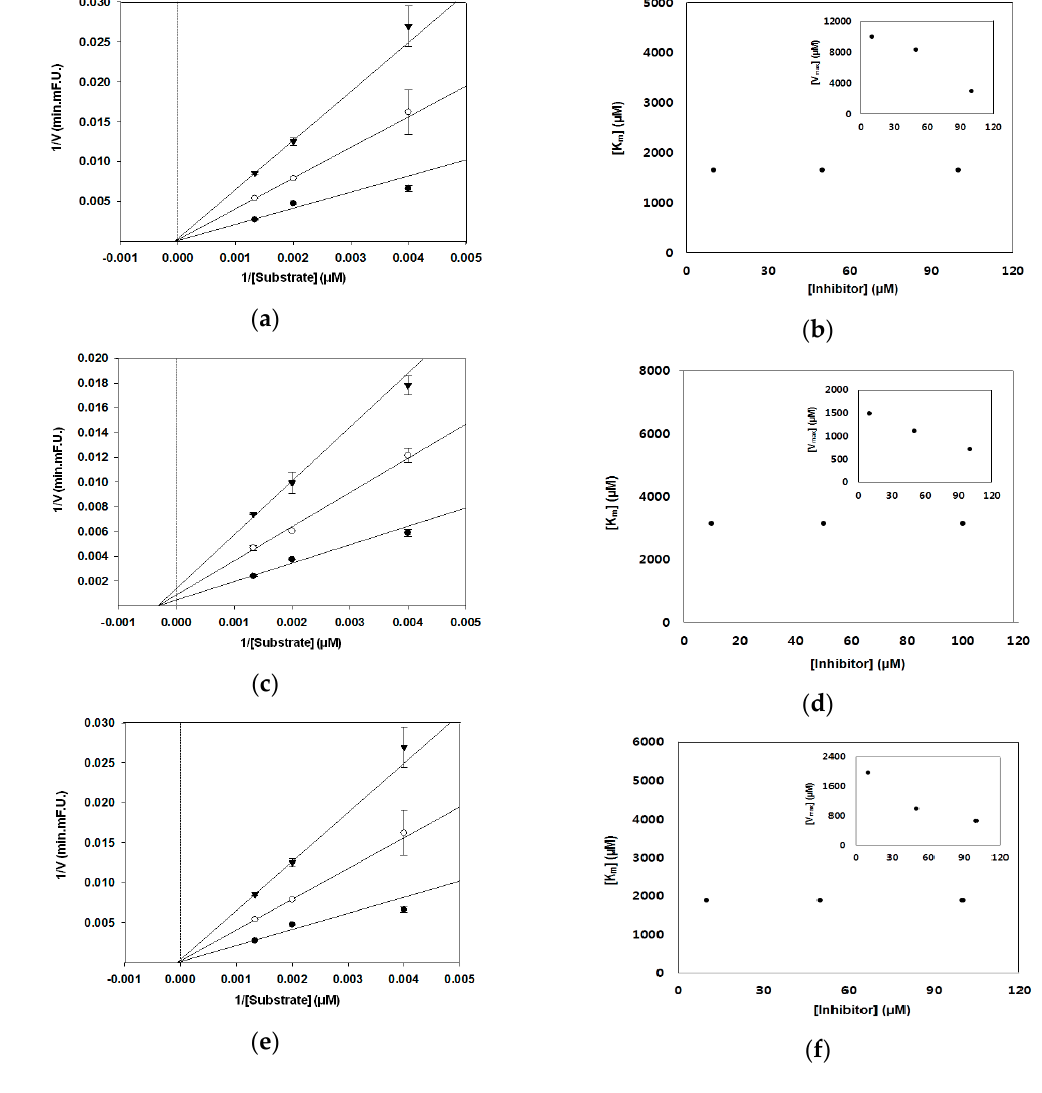
Figure 3. Lineweaver–Burk plot of the reciprocal initial velocities of ( a ) nobiletin, ( c ) tangeretin, and ( e ) sinensetin against BACE1 concentration at different polymethoxyflavone (PMF) concentrations: 10 M ( ● ); 50 μ M ( ○ ); 100 μ M ( ▼ ). The Km values as a function of the concentration of ( b ) nobiletin, ( d ) tangeretin, and ( f ) sinensetin. Insets in ( b ), ( d ), ( f ) show the dependence of the values of Vmax on the concentration of PMFs.